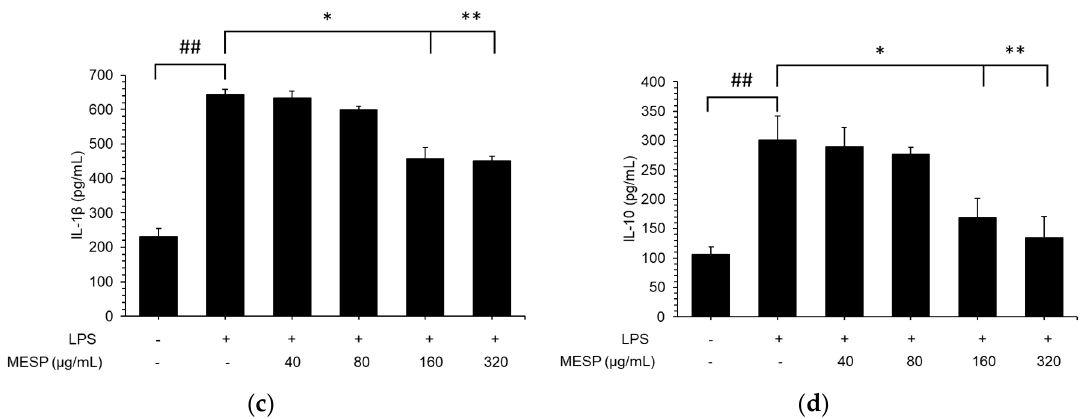
Figure 4. Inhibitory effects of MESP on TNF- α ( a ), IL-6 ( b ), IL-1 β ( c ), IL-10 ( d ) production on RAW 264.7 cells by ELISA. Values are expressed as mean ± SD ( n = 3). ## p < 0.01, compared to the control group; * p < 0.05, ** p < 0.01, compared to the LPS treated group.